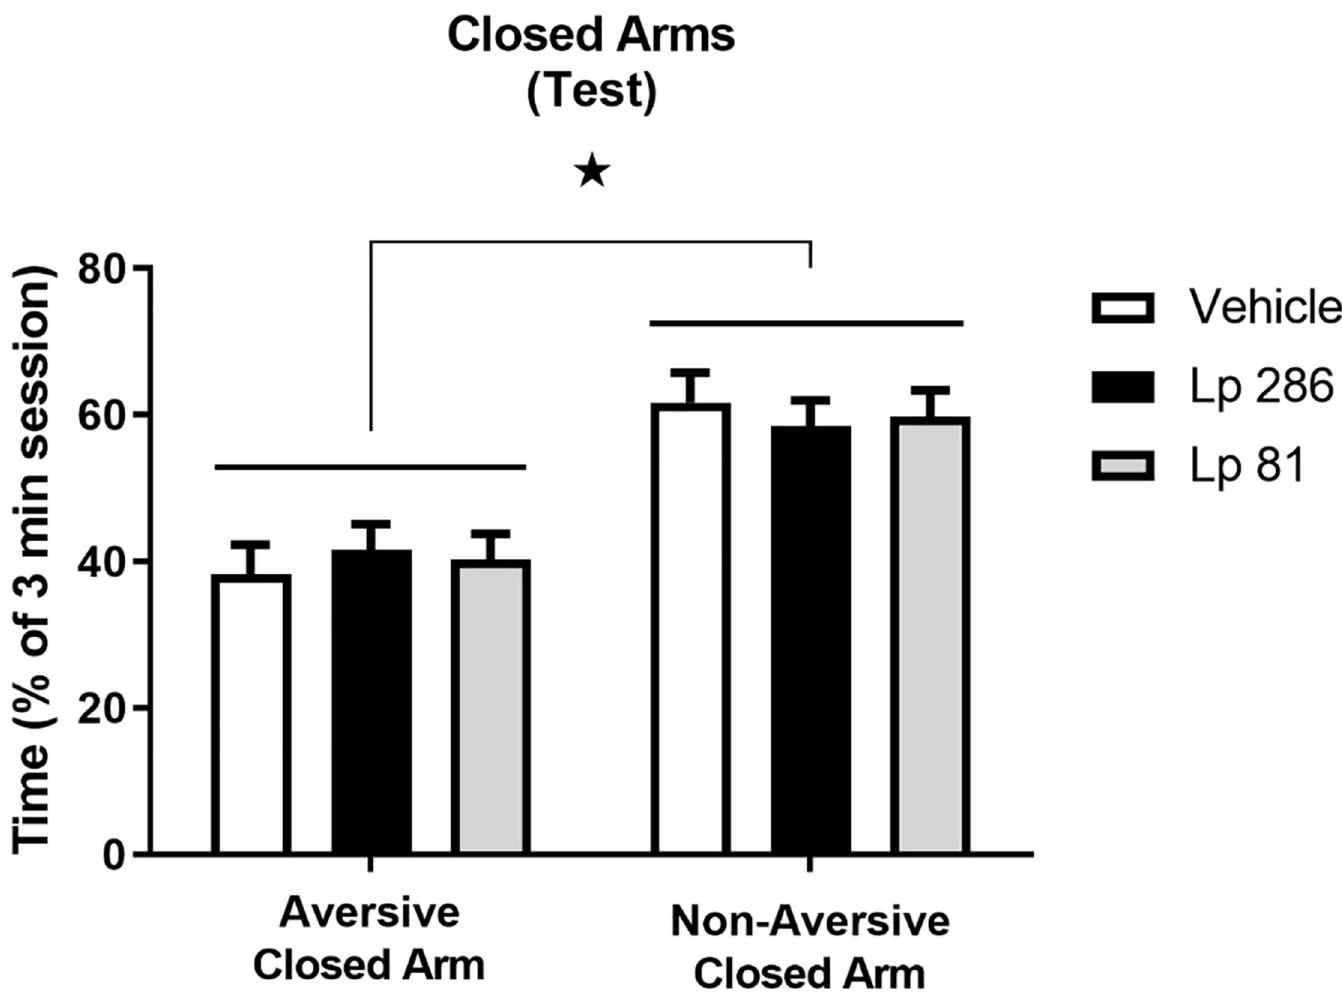
Fig 5. Time spent in the aversive vs non-aversive closed arms of the modified elevated plus-maze during the test session of the plus-maze discriminative avoidance test. Test was performed on the day after the training session after once/daily treatment (oral gavage) with vehicle, Lactobacillus plantarum 286 (Lp 286, 10e9UFC/0.1 mL) or Lactobacillus plantarum 81 (Lp 81, 10e9 UFC/0.1 mL) solutions. Comparison of the time spent in the aversive vs non-aversive closed arms during the 3-minute test session. Data are expressed as % of the 3-minute session spent in each arm of the apparatus, and presented as mean ± SEM. Two-way repeated measures ANOVA followed by Bonferroni t-test. � p < 0.05 compared to the aversive closed arm.